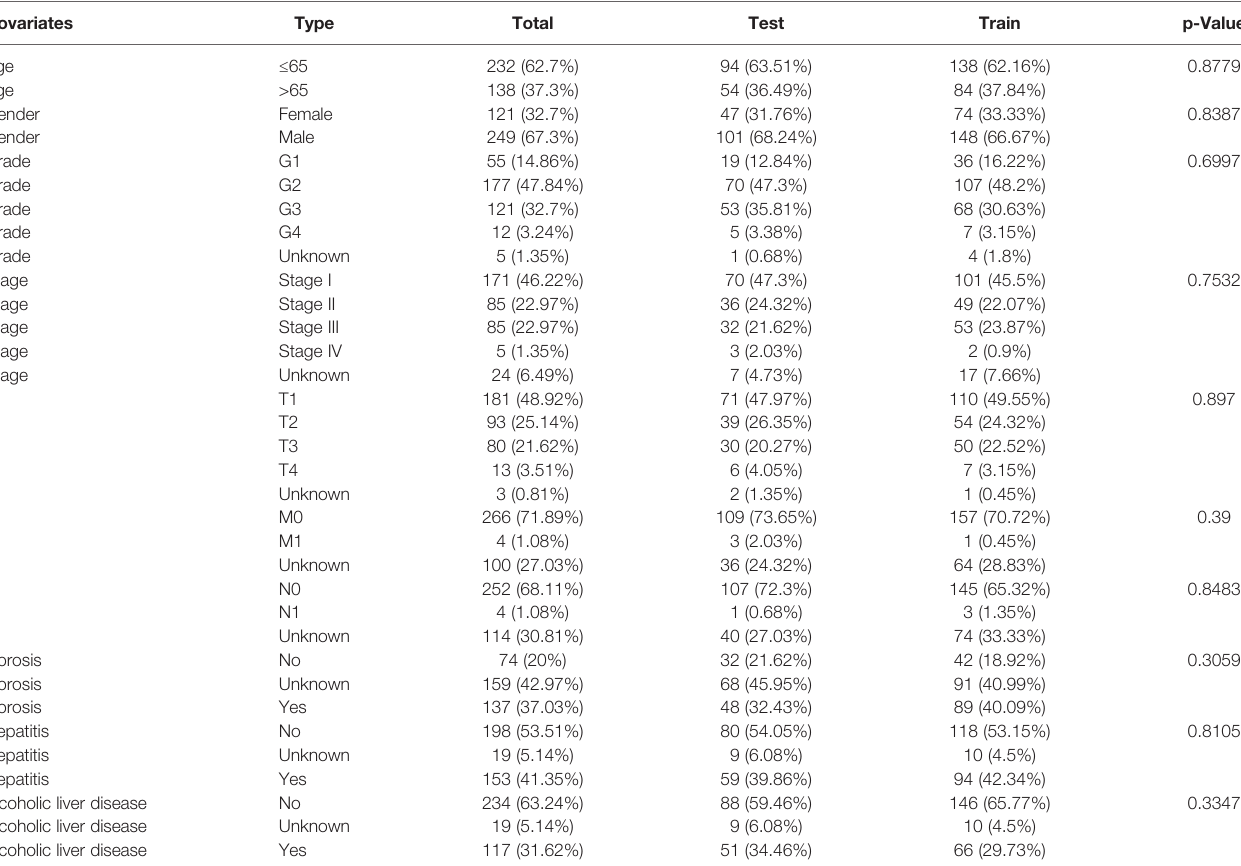
TABLE 1 | The clinical information of HCC patients obtained from the UCSC Xena browser.